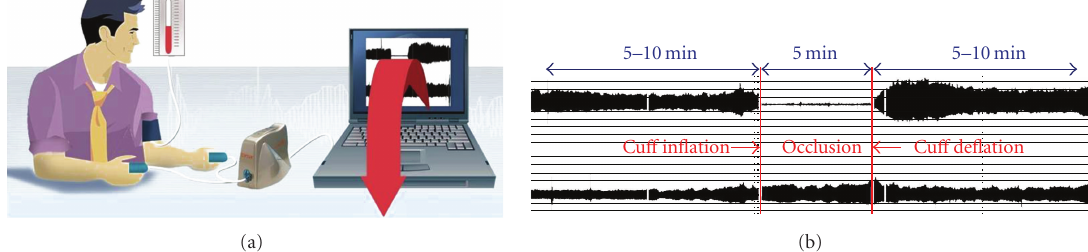
Figure 3: Diagram of the Endo-PAT set-up (a). (b) Representative traces from both the study and control arms showing the changes on the pulse amplitude after a 5-minute period of occlusion (printed with permission of Itamar